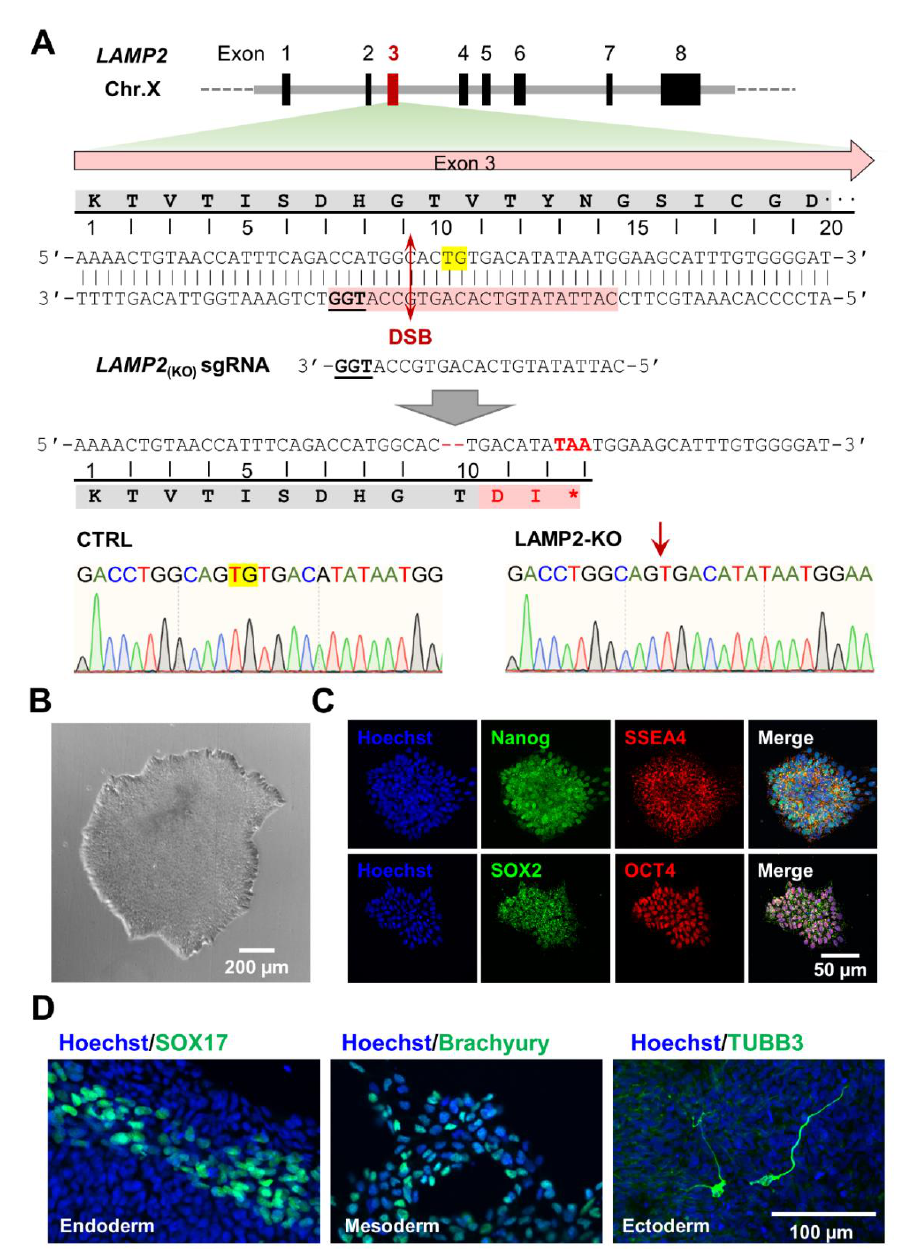
Figure 1. Generation of LAMP2 knock out iPSC model of Danon disease. ( A ) Top: LAMP2 gene structure and design of small guide RNA for CRISPR/Cas9 knockout. Middle: error-prone repairs of double strand break (DSB) induced a 2-base deletion in exon 3 of LAMP2 , which results in an early stop codon that truncates LAMP2. Bottom: Sequence chromatograms showed the result of gene editing. Yellow background highlights the deleted nucleotides. * indicates stop codon that induce truncation of LAMP2; ( B ) LAMP2 KO iPSCs exhibit the typical stem cell clone morphology as shown in phase contrast view; ( C ) Immuno-fluorescence staining shows the expression of pluripotency markers (Nanog, SSEA-4, SOX2, and OCT4) in LAMP2 KO iPSCs; ( D ) In vitro 3-germ layer differentiation of LAMP2 KO iPSCs was confirmed by the immunofluorescence staining of specific markers: SOX17 for endoderm, Brachyury for mesoderm, and γ -tubulin for